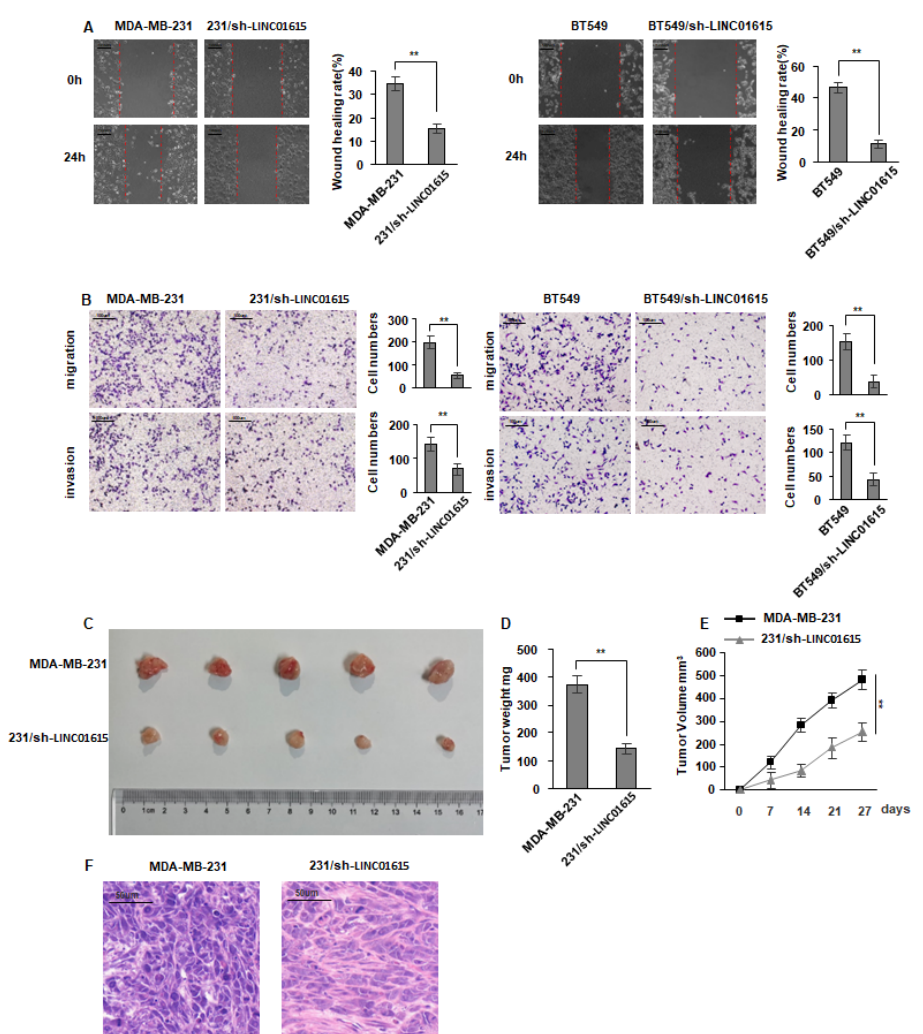
Figure 3. LINC01615 promotes migration and invasion of breast cancer cells. ( A , B ) BT549 and MDA-MB-231 cells were transduced with shLINC01615 or shNC as indicated. Cell metastasis was determined by Scratch wound assays ( A ) or Transwell migration and Matrigel invasion assays ( B ). ( C , D ) Subcutaneous xenografts of breast cancer cells infected with LINC01615 knockdown lentivirus (sh) or control lentivirus (shNC). ( C ) Images of the tumors at autopsy from nude mice are presented. ( D , E ) Tumor weight and volume of xenografted tumors were measured, respectively. ( F ) Representative H&E-stained sections of the tumor tissues isolated from mice. Data represent the means ± SD. ** p < 0.01.